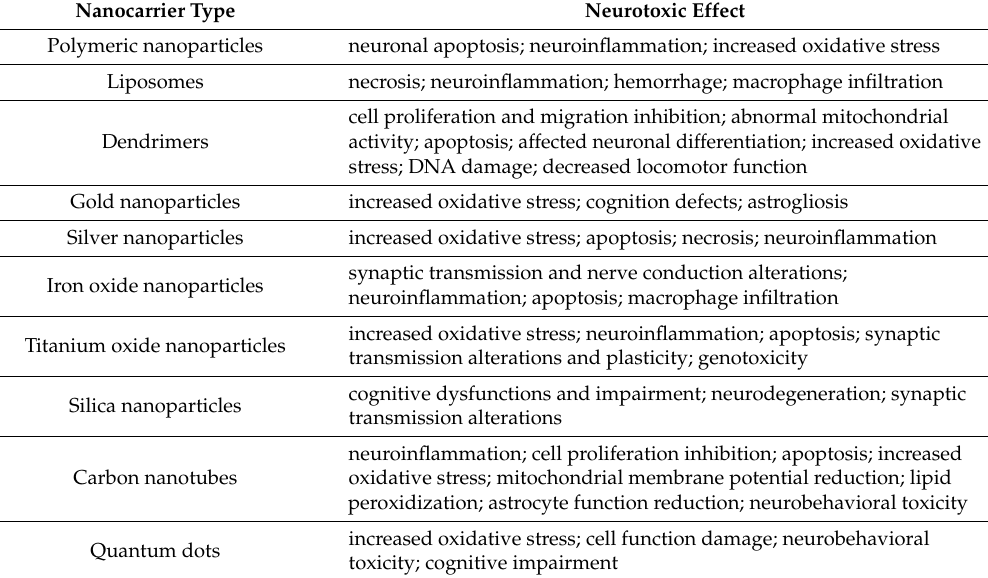
Table 4. A summary of the main neurotoxic effects of the organic and inorganic nanocarriers for BBB crossing